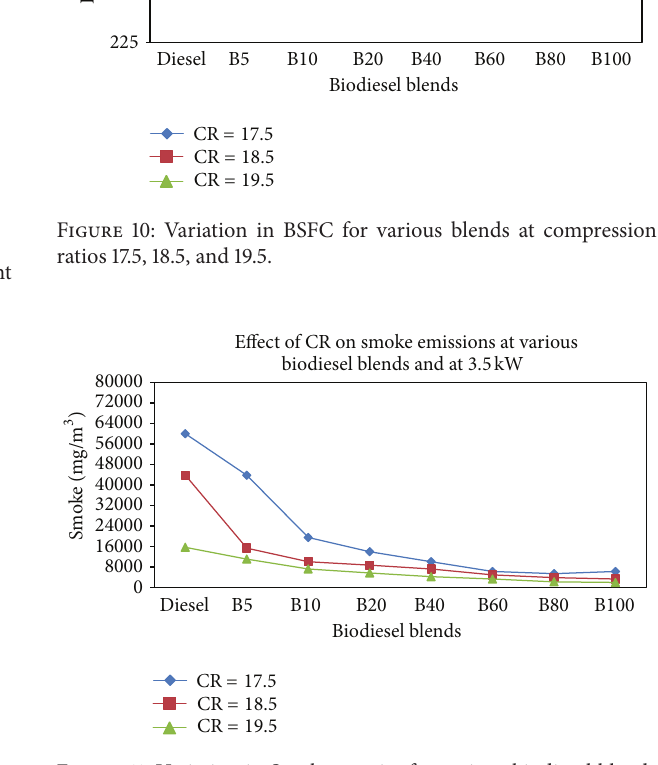
Figure 11: Variation in Smoke opacity for various biodiesel blends at compression ratios 17.5, 18.5, and